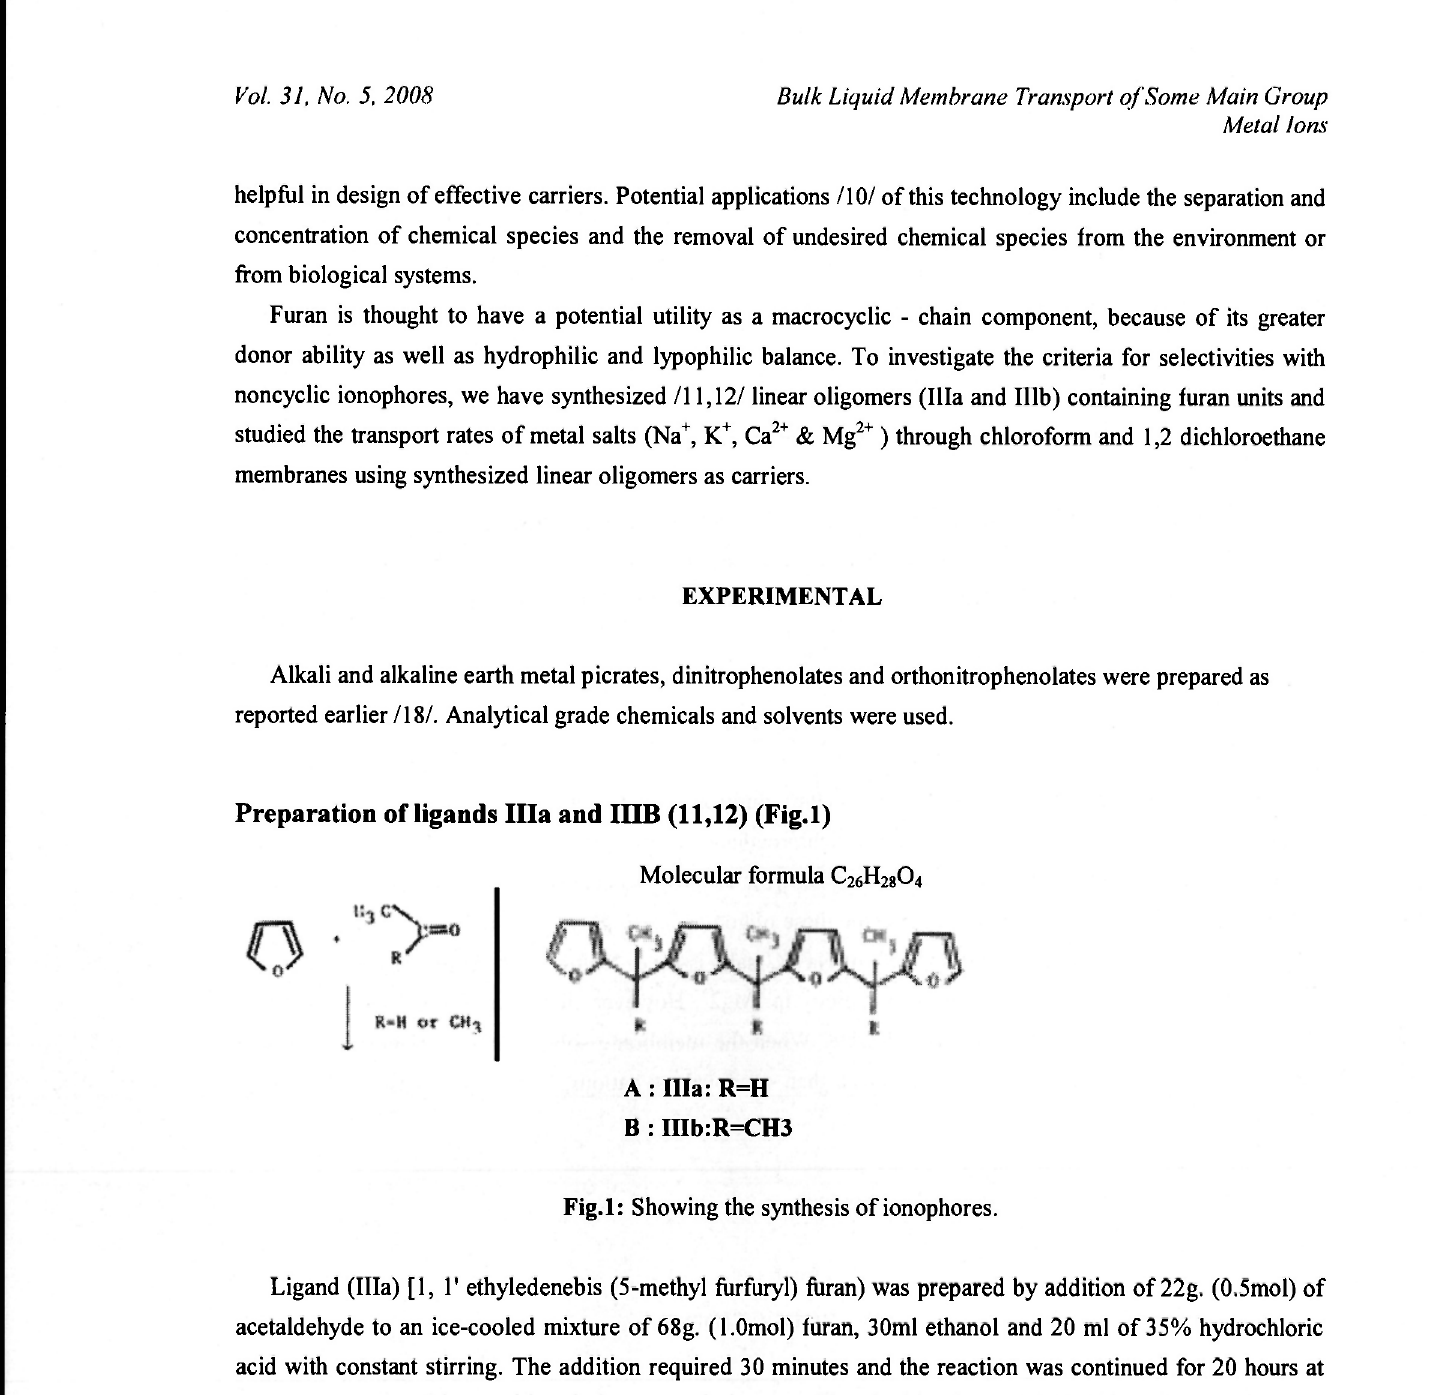
Fig.l: Showing the synthesis of